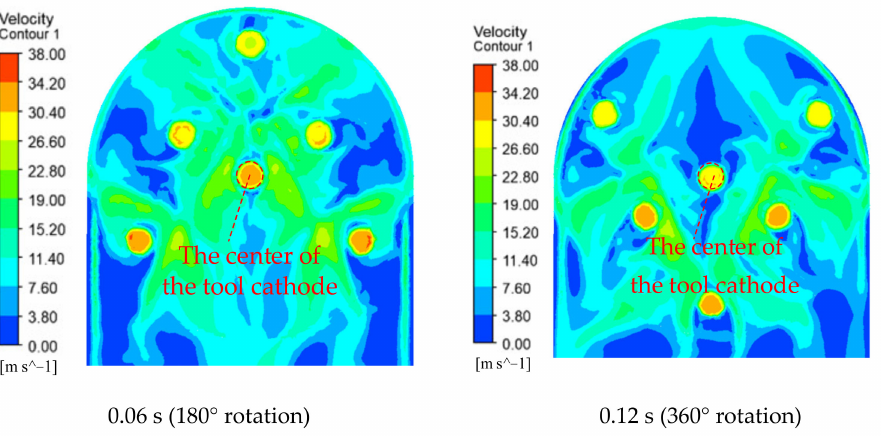
Figure 4. Electrolyte velocity distribution in the machining gap at different times using tool